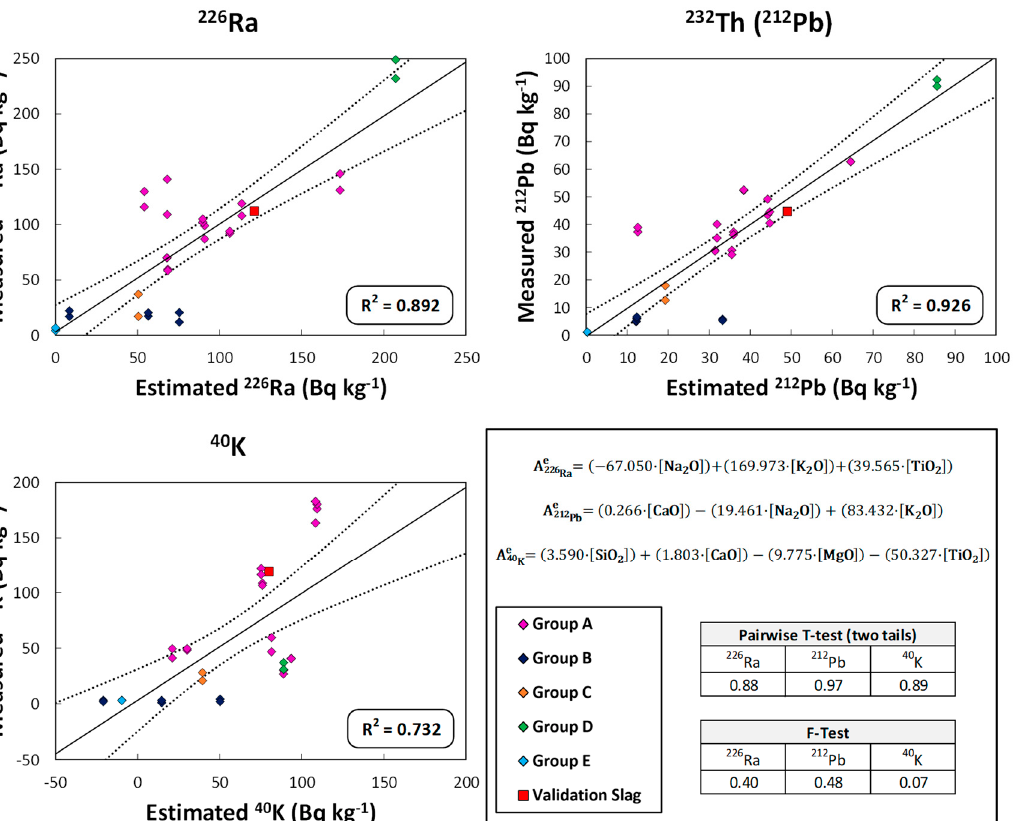
Figure 8. Graphical representation of the activity concentration values of 226 Ra, 232 Th( 212 Pb), and 40 K measured experimentally versus those estimated using the models obtained that relate the chemical composition of the cements to the activity concentration of the different radionuclides. The models explain more than 73% of the dispersion. The clusters represented by the confidence ellipses in Figure 5 are shown with the same color at the represented points. Comparison between experimental and estimated values showed no significant differences, as the p -value for the paired t -test and Fisher’s F-test were above the α significance value of 0.05. The results obtained in the validation of the method are included for agreement with the proposed model.